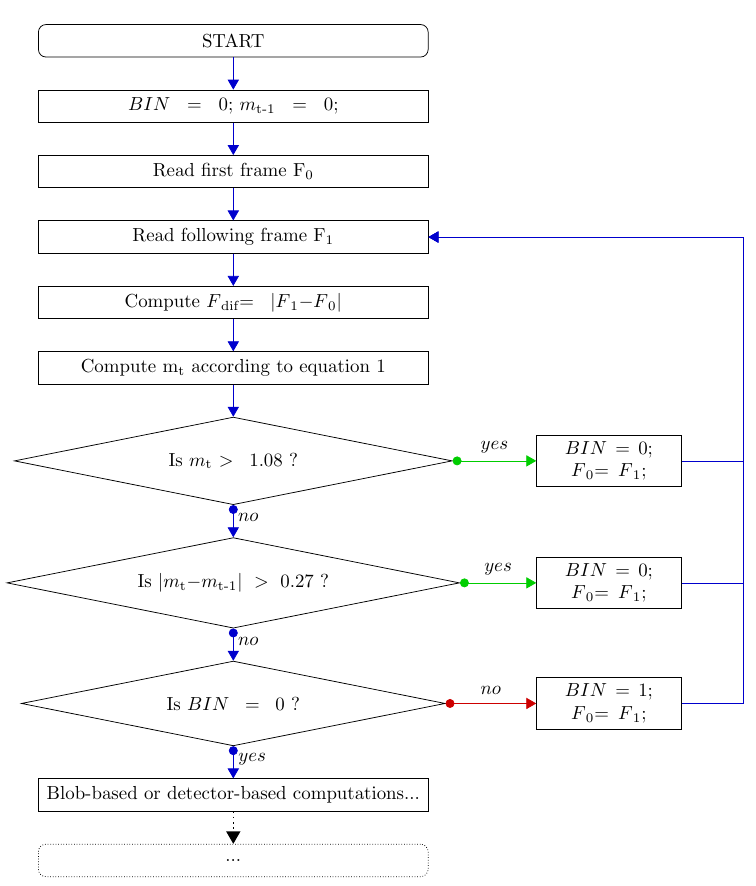
Figure 3. Detailed flowchart of the Motion Check